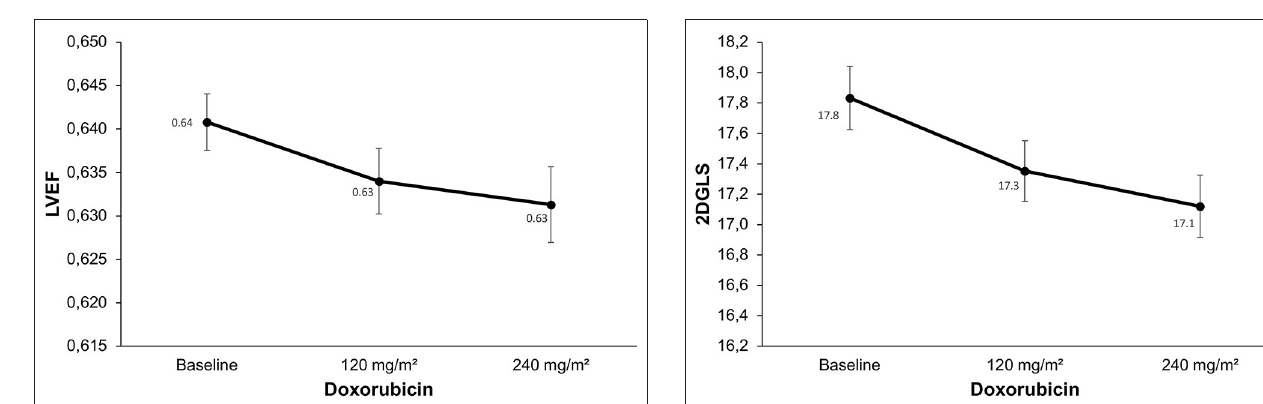
FIGURE 3 | Changes in global longitudinal strain derived from the two-dimensional speckle tracking echocardiography. Compared to baseline, two-dimensional global longitudinal strain (2DGLS) did not change earlier, after 120 mg/m 2 of doxorubicin ( p < 0.103). There was a decrease in 2DGLS after 240 mg/m 2 of doxorubicin compared to baseline ( p < 0.001). However, the relative change of 2DGLS was mild, with no patient presenting criteria for the diagnosis of subclinical